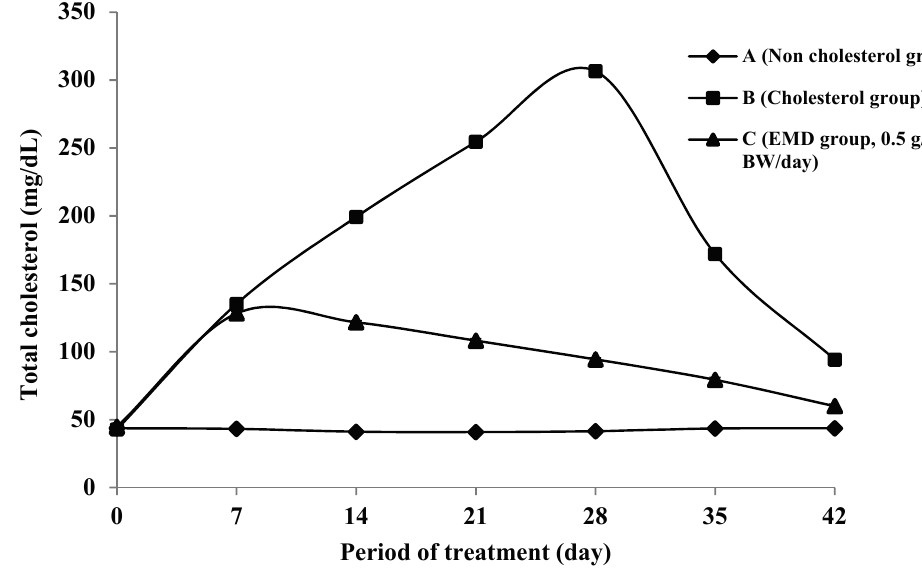
Figure 3. The changes of total cholesterol level during treatment on groups of non-cholesterol (A) ( ♦ ); cholesterol (B) ( ■ ); and EMD 0.5 g/kgbw(C) ( ▲